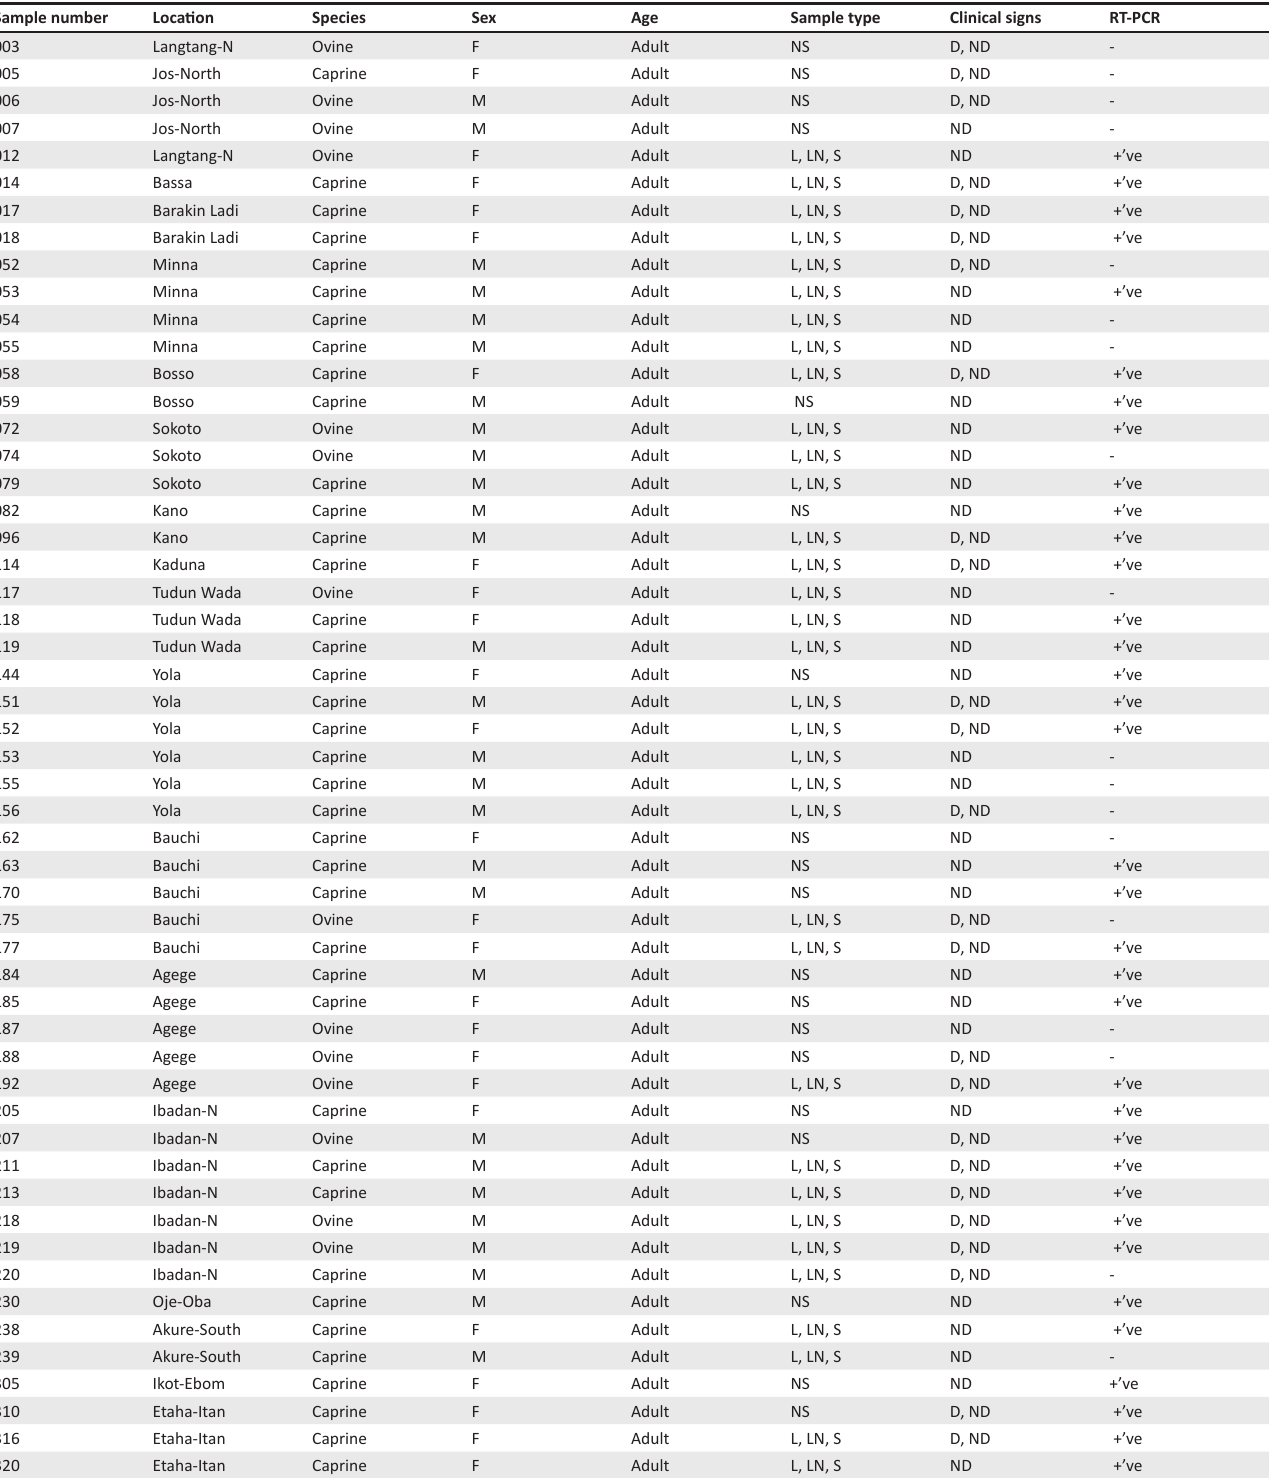
TABLE 1: Description of the animals and samples that tested positive for peste-des-petits-ruminants virus by Verso One-Step reverse transcriptase. Tissue samples were pooled. Sample